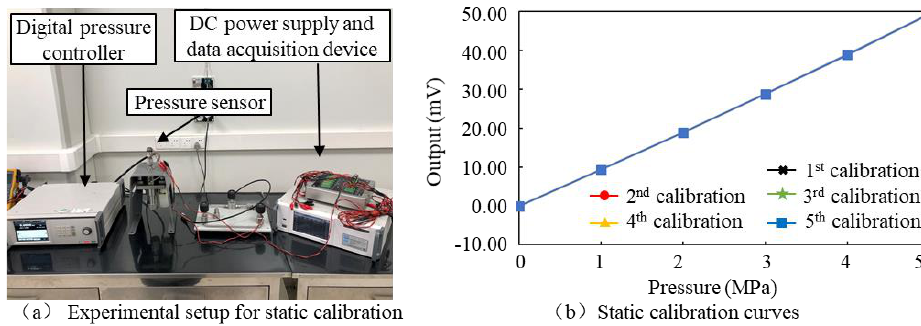
Figure 10. Experimental setup ( a ) and output curves ( b ) of static calibration. Table 2. Sensor’s output voltage in static calibration.